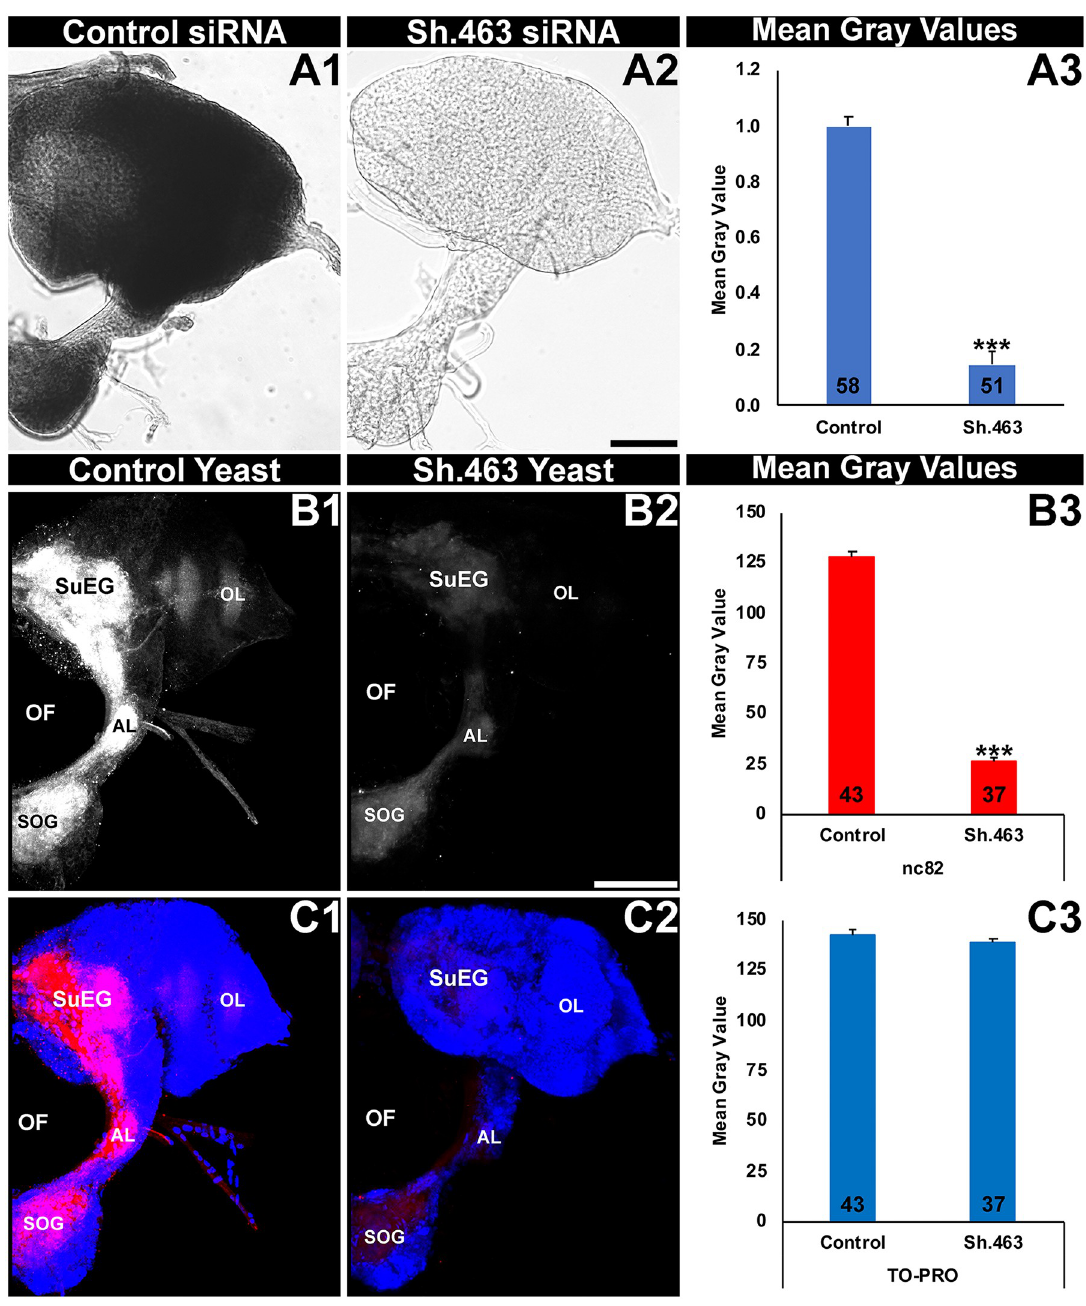
Fig 5. Sh.463 yeast induces neural defects in A . aegypti larvae. High levels of Aae Sh expression detected throughout the A . aegypti L4 larval brain (the brain from a control yeast-treated larva is shown in A1) are significantly reduced (A3) in the L4 brain of larvae fed with Sh.463 yeast (A2). Mean gray value analysis results are displayed in A3. Larval brains were labeled with mAbnc82 (white in B1, B2; red in C1, C2) and TO-PRO (blue in C1, C2). nc82 levels were significantly reduced (B3) in the synaptic neuropil of larvae fed with Sh.463 yeast (B2, C2; compare to control-treated brain in B1, C1). In B3 and C3, data are represented as average mean gray values. In A3, B3, and C3, error bars denote SEM, and ��� = P < 0.001 when compared with brains from control yeast-treated larvae. Representative adult brains are oriented dorsal upward in this figure. AL: antennal lobe; OL: optic lobe; SOG: sub-esophageal ganglion; SuEG: supra- esophageal ganglion. Scale Bar = 100 μ m.